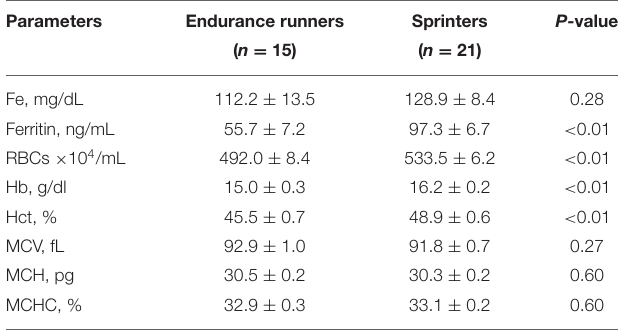
TABLE 1 | Comparison anthropometric characteristics between endurance runners and sprinters. Parameters